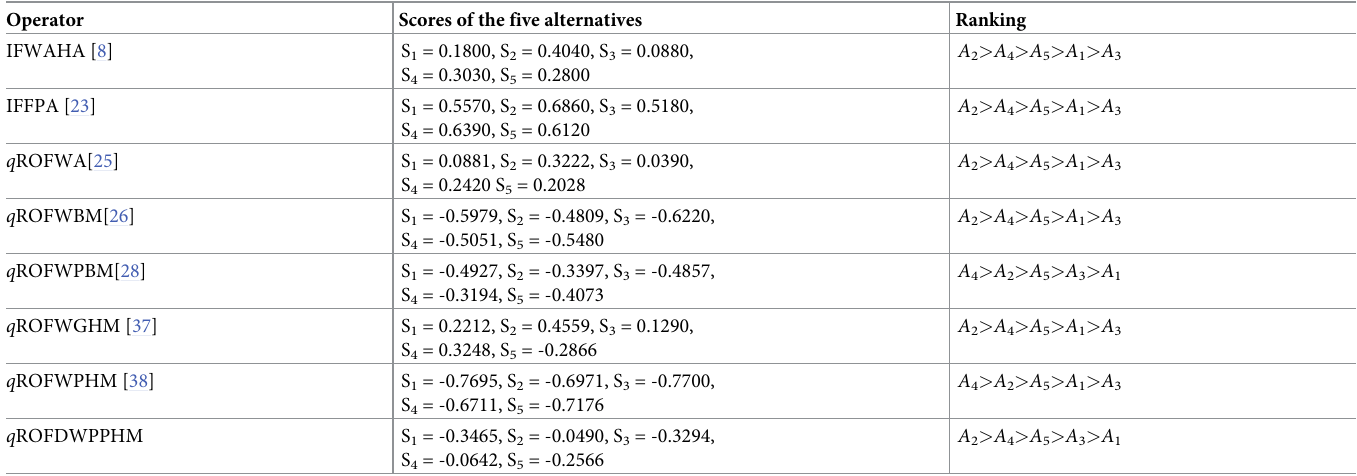
Table 11. The results of quantitative